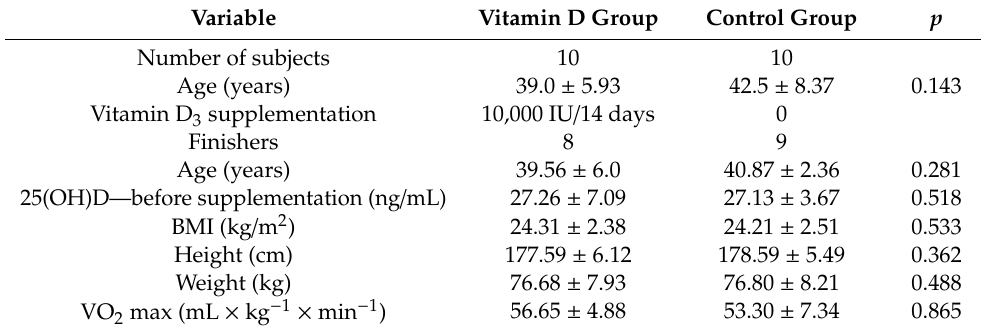
Table 1. Comparison of subjects’ baseline characteristics (mean ± standard deviation).